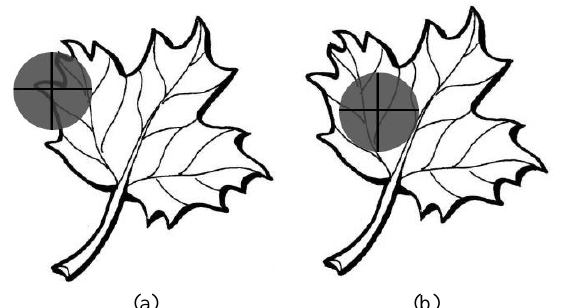
Figure 3. Sketch map of the position relationship between laser beam and single